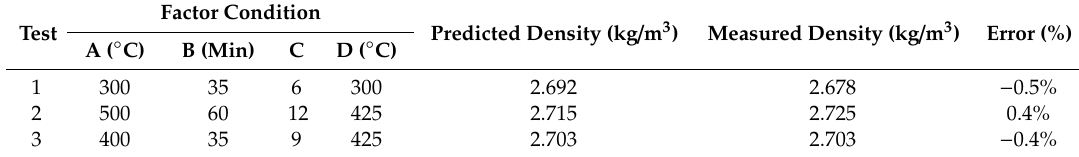
Table 4. Model validation experiment.